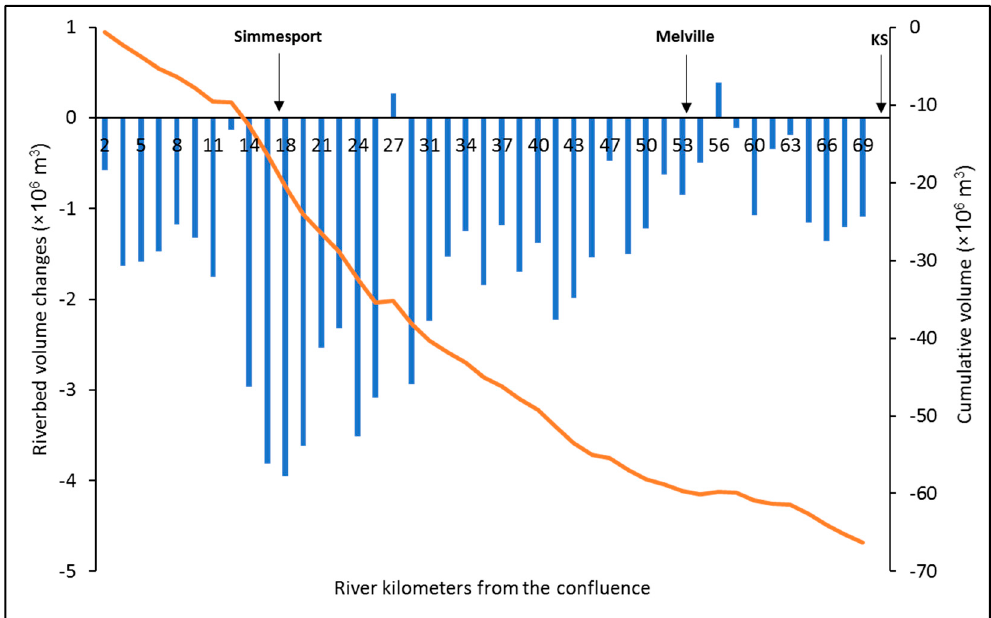
Figure 7. Volume changes of riverbed sediment during 1998–2006 in the uppermost Atchafalaya River. The channel is a 69-km reach downstream of the Outflow Channel (OC) outlet of the Mississippi-Atchafalaya River diversion (RK 0). The orange line is the cumulative sediment volume.